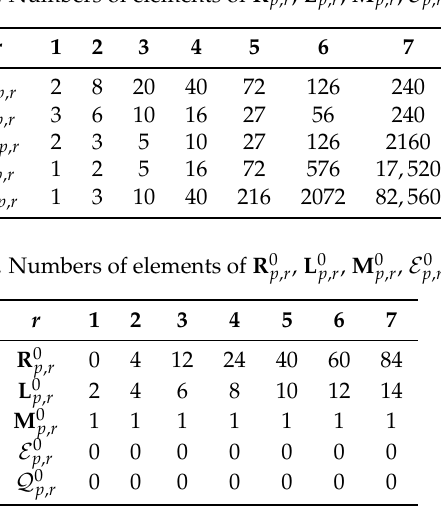
Table 1. Numbers of elements of R p , r , L p , r , M p , r , E p , r , Q p , r .